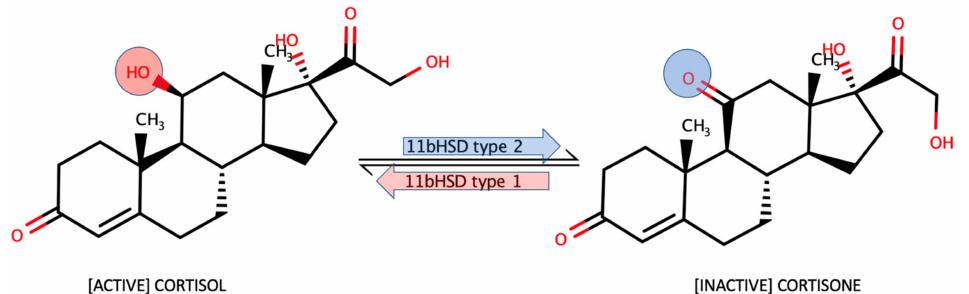
Figure 1. Cortisol–cortisone 11 β HSD isoenzyme 1–2